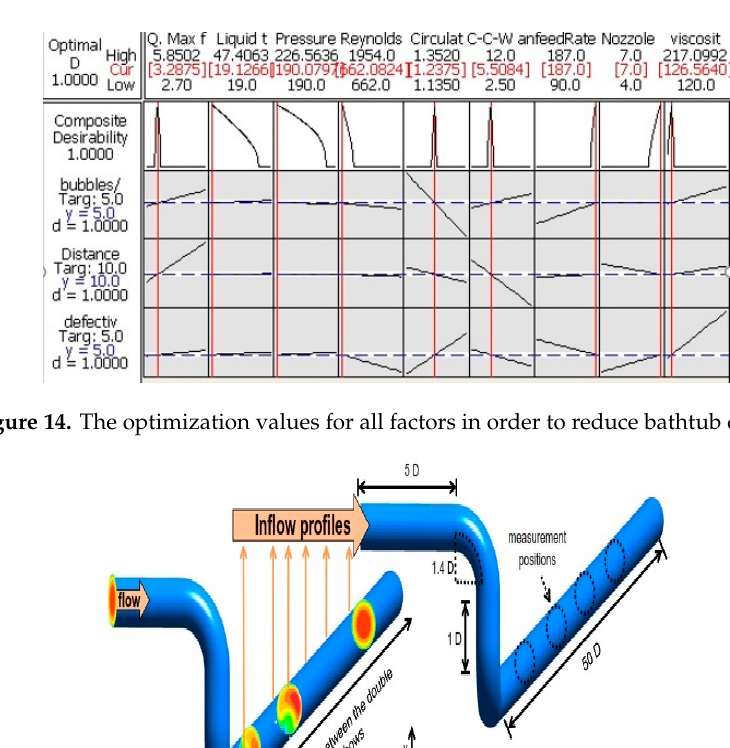
Figure 16. Type 1, Disturbance and double helix waste.